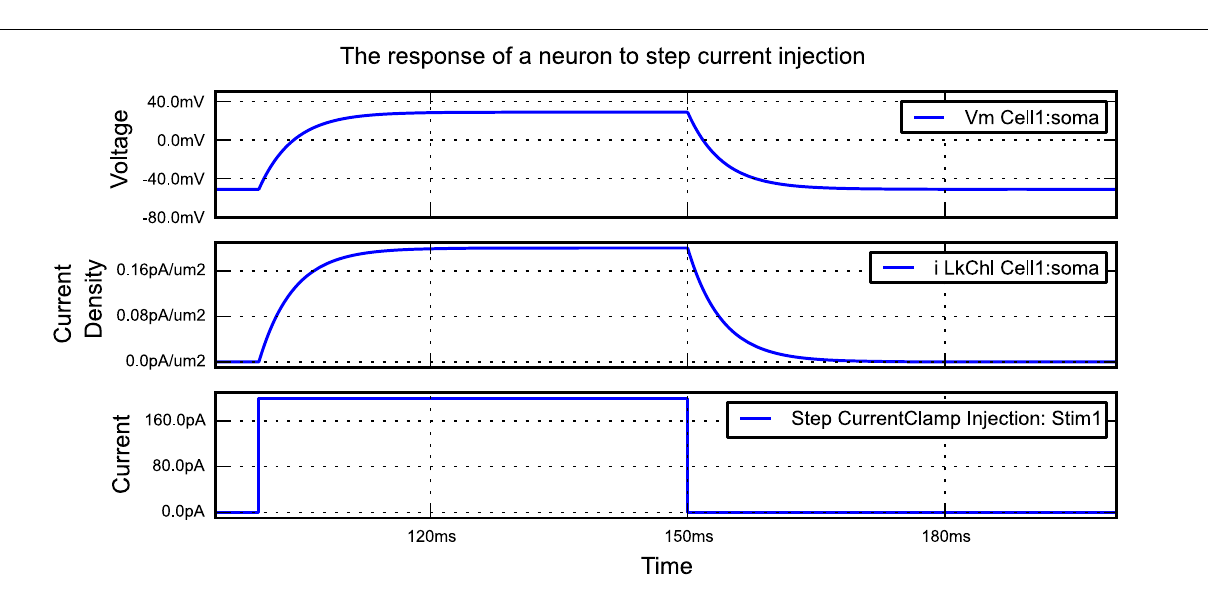
plotting is performed automatically by the TagViewer